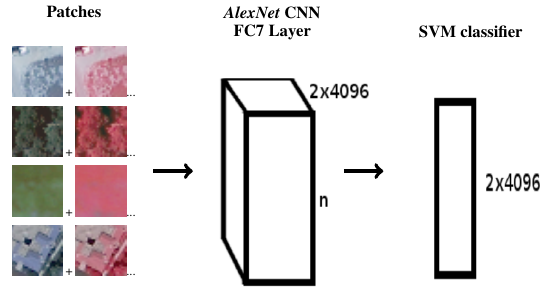
Figure 2: The FC7 layer of the Pretrained AlexNet network has been employed for extracting features and train a SVM classifier. Two different band combinations (red-green-bue and NIR-red- green) have been formulated in order to exploit all the available spectral